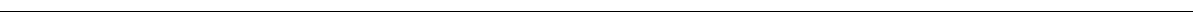
Fig. 7 Phosphorylation of GEF-H1 by CaMKI increased its GEF activity. a NT-3-induced minor neurite retraction was abolished by knockdown of GEF-H1 (siCont/PBS = 29, siCont/NT-3 = 26, siGEF-H1#2/PBS = 23, siGEF-H1#2/NT-3 = 26 neurites from three independent experiments). b The increase in FRET ef fi ciency in the cell body induced by NT-3 was abolished by knockdown of GEF-H1 (siCont/PBS = 5, siCont/NT-3 = 8, siGEF-H1#2/PBS = 6, siGEF-H1#2/NT-3 = 15 neurons from three independent experiments). c CaMKI increased the GEF activity of GEF-H1. GEF-H1 was co-transfected with myc-CaMKI-WT, -CA or – KD into COS-7 cells. The cell extracts were incubated with GST-RhoA-G17A-bound beads. Active GEF-H1 was pulled down and detected by immunoblotting with anti-myc (top). Total GEF-H1 and CaMKI were detected by immunoblotting with anti-myc ( middle and bottom , respectively). d Bar graphs indicate the ratio of GEF-H1 activity. e The phospho-mimic mutant GEF-H1 exhibited an increment in GEF activity. Cell lysates expressing GEF-H1 – WT, – T103A or – T103E were incubated with GST-RhoA-G17A-bound beads. Active ( top ) or total ( bottom ) GEF-H1 was detected by immunoblotting with an anti-myc antibody. f Bar graphs indicate the ratio of GEF-H1 activity. g myc-GST (Cont), myc-GEF-H1 – WT, – T103A or – T103E was transfected into neurons at 3 DIV. Representative images of the neurons at 4 DIV are shown. Scale bars represent 100 μ m. h The percentages of neurons with multiple Tau-1-positive axons. i Bar graphs indicate the ratio of multiple axonal lengths. j , k The length of the longest neurite i and the total neurite length j were determined (GST = 86, GEF-H1 WT = 90, GEF-H1 T103E = 88, GEF-H1 T103A = 90 neurons from three independent experiments). Error bars represent SEM. * P < 0.05 and ** P <